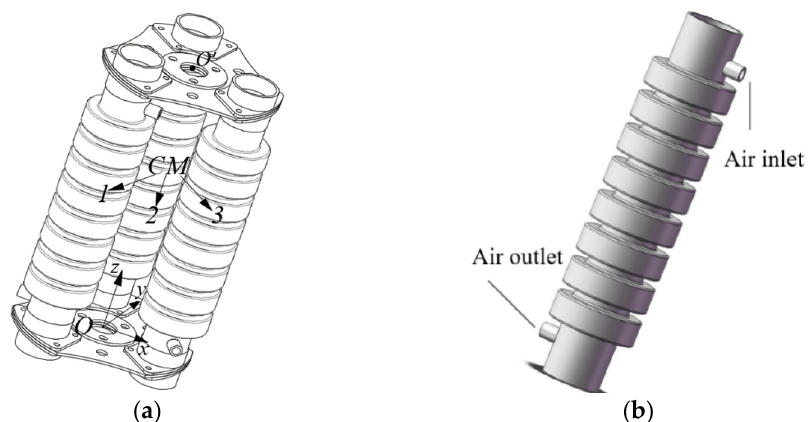
Figure 2. Photo of the novel flexible connecting plate.